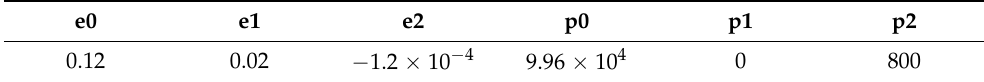
Figure 5. Validation of the model for the Rotax 912 with datasheet values and simulated efficiency: ( a ) tuning of the model with datasheet information; ( b ) resulting efficiency map of the Rotax912UL. Table 2. The coefficients for the Willans line model for the Rotax